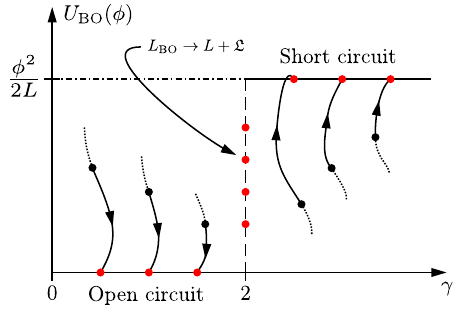
FIG. 10. A conceptual flow diagram describing the fixed-point structure of a nearly singular circuit. Referring to Fig. 4, flows are parametrized by the small capacitor C 0 , with the fixed points (red dots) reached when C 0 → 0 . Actual computations of the flows are performed by finding the ground state of the fast-variable Schrödinger equation in the Born-Oppenheimer treatment. The object that flows is the entire Born-Oppenheimer potential function U · Þ exemplified here as just one parameter, the BO ð ϕ Þ at some particular value of the slow variable ϕ . value U BO ð The flows are shown for different forms of the potential of the nonlinear inductor schematized here by parameter γ , as in the γ ; cf. Eq. (20). Flows start at some ϕ ∼ j ϕ potential form U c Þ c j NL ð nonuniversal values (black dots); the flows are in reality in a high- dimensional parameter space and are not necessarily monotone, as schematized by the waviness of the flow lines. We show that sublinear cases ( 0 < γ < 2 , type 1) all flow to the universal open- ϕ Þ ¼ 0 ; superlinear cases ( γ > 2 , circuit fixed point with U BO ð type 2) all flow to the universal short-circuit fixed point with ϕ Þ ¼ ϕ 2 = 2 L . Linear or quasilinear cases (type L ) remain U BO ð fixed at γ ¼ 2 , flowing to a point on the dashed line determined by the starting parameter L ; cf. Theorem